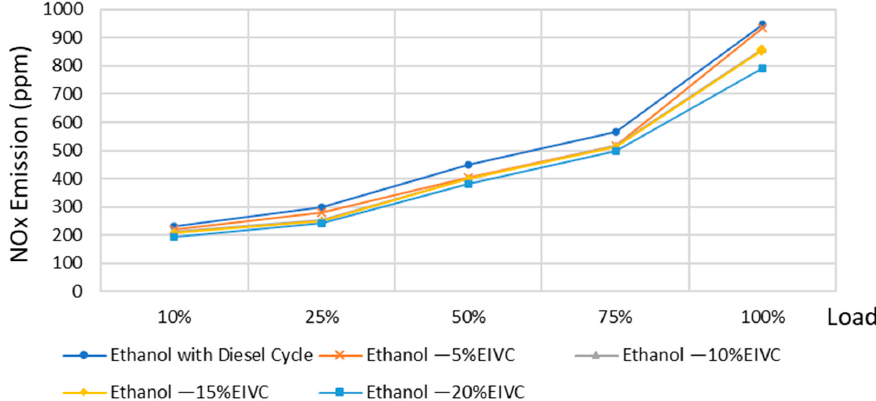
Figure 18. NOx emission(ppm) of ethanol engine with EIVC Miller Cycle.